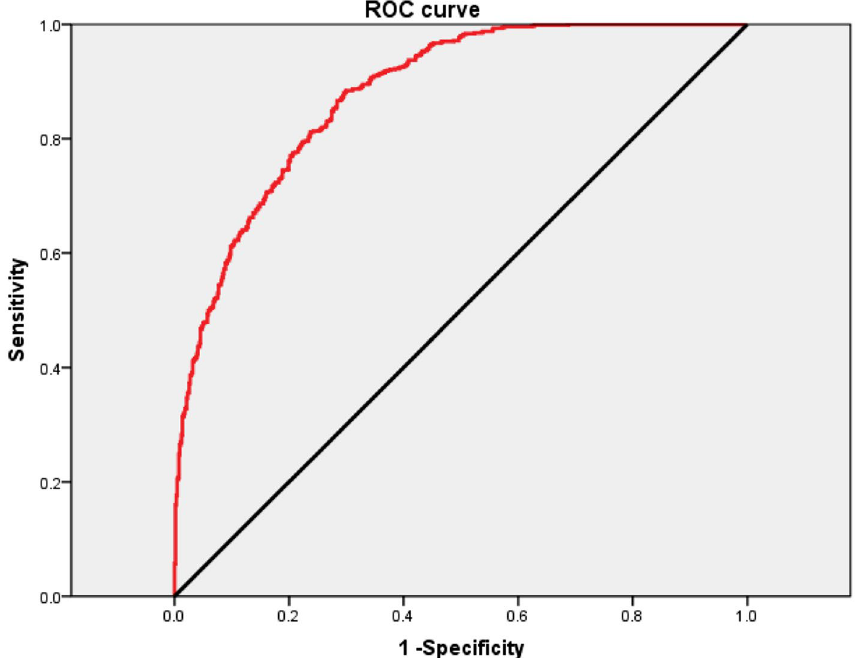
Figure 1. ROC of characteristics to predict euploidy of blatocysts. The ROC curve was showed in red and the black one was the reference line. X-axis showed the 1-specificity and Y-axis showed the